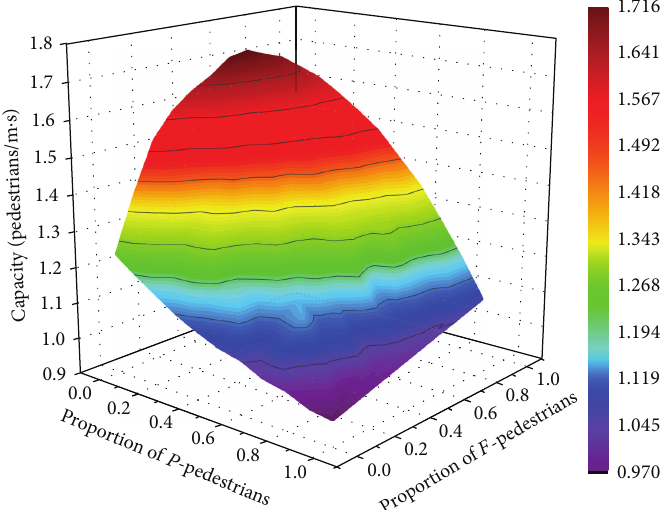
Figure 12: The contour map of capacity under all kinds of heterogeneous parameter